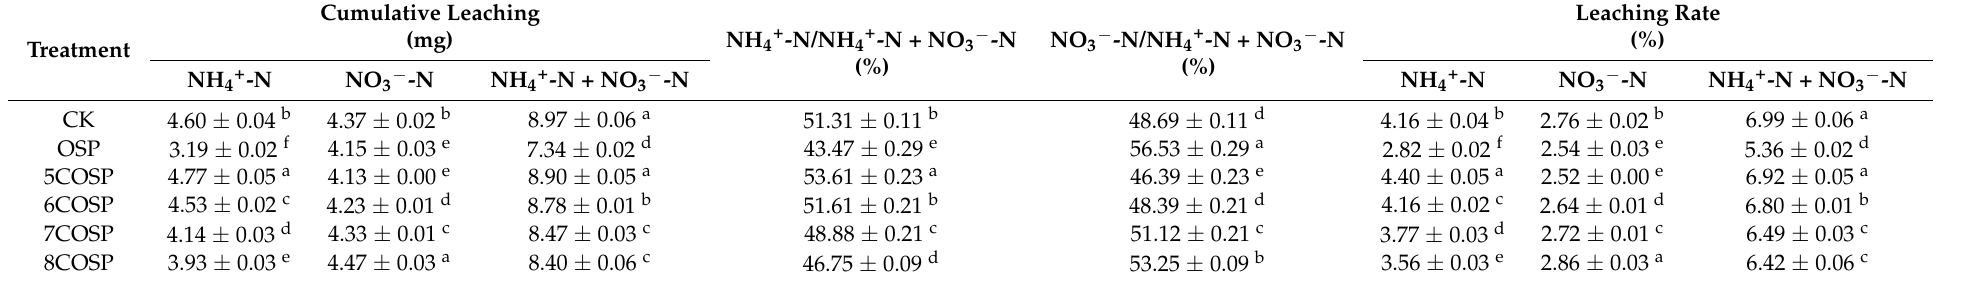
Table 4. Cumulative leaching amount and rate of NH 4+ -N and NO 3 − -N under the treatments.